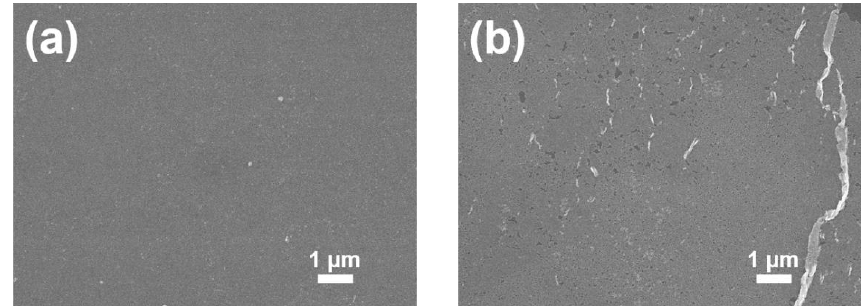
Figure 7. Schematic illustration of mechanism of oleic acid-assisted self-assembly of BT nanocubes. The extra oleic acid added to the water surface exerts a compression pressure on BT nanocubes, which are carried to the evaporation front by convective flows. This compression pressure confines the BT nanocubes around the suspension droplet and assists the lateral capillary forces to work between the BT nanocubes.